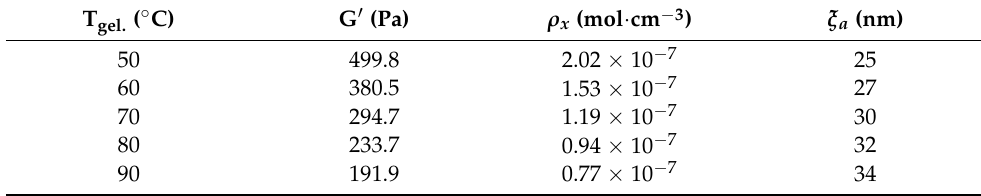
Table 3. Values of crosslinking density, ρ x , and network mesh-size values, ξ a , of the hydrogels, calcu- lated from Equations (6) and (7), respectively. All experimental parameters as specified in Figure